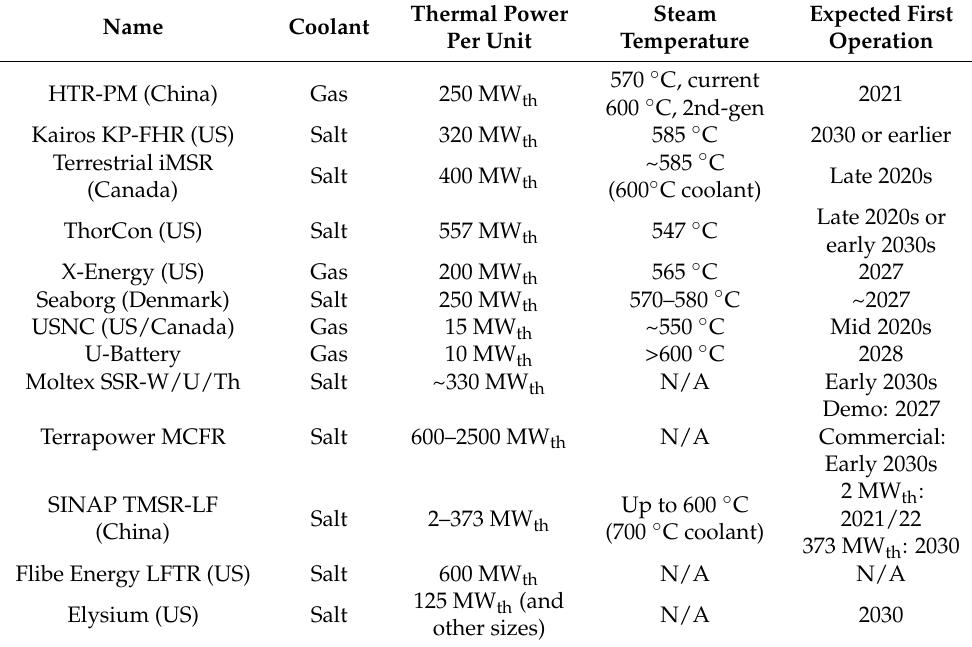
Table 7. Examples of applicable gas and salt cooled nuclear reactors under